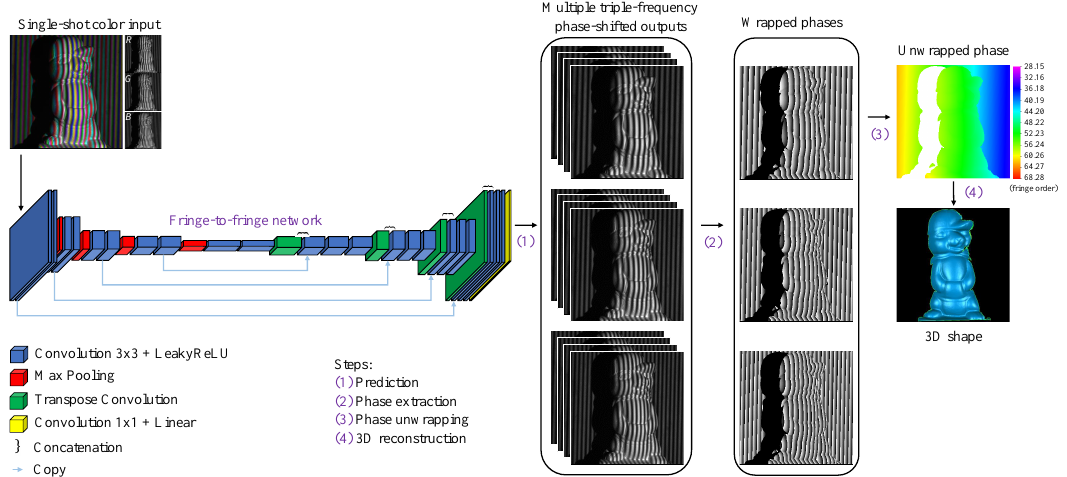
Figure 1. Pipeline of the proposed